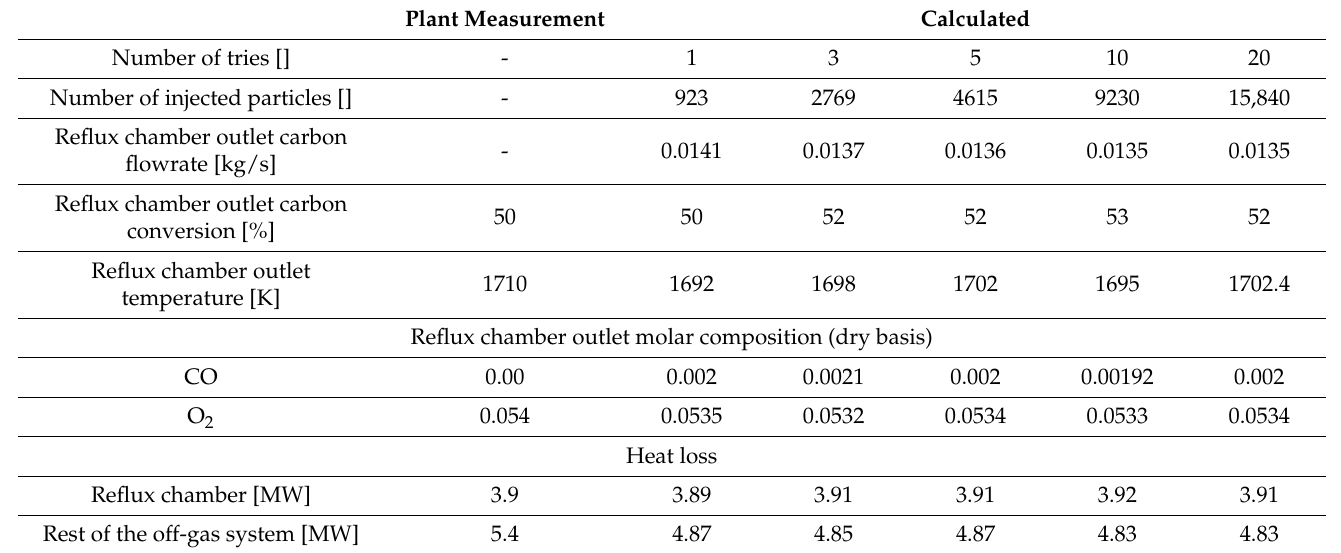
Table 10. Effect of NTs on predicated values.